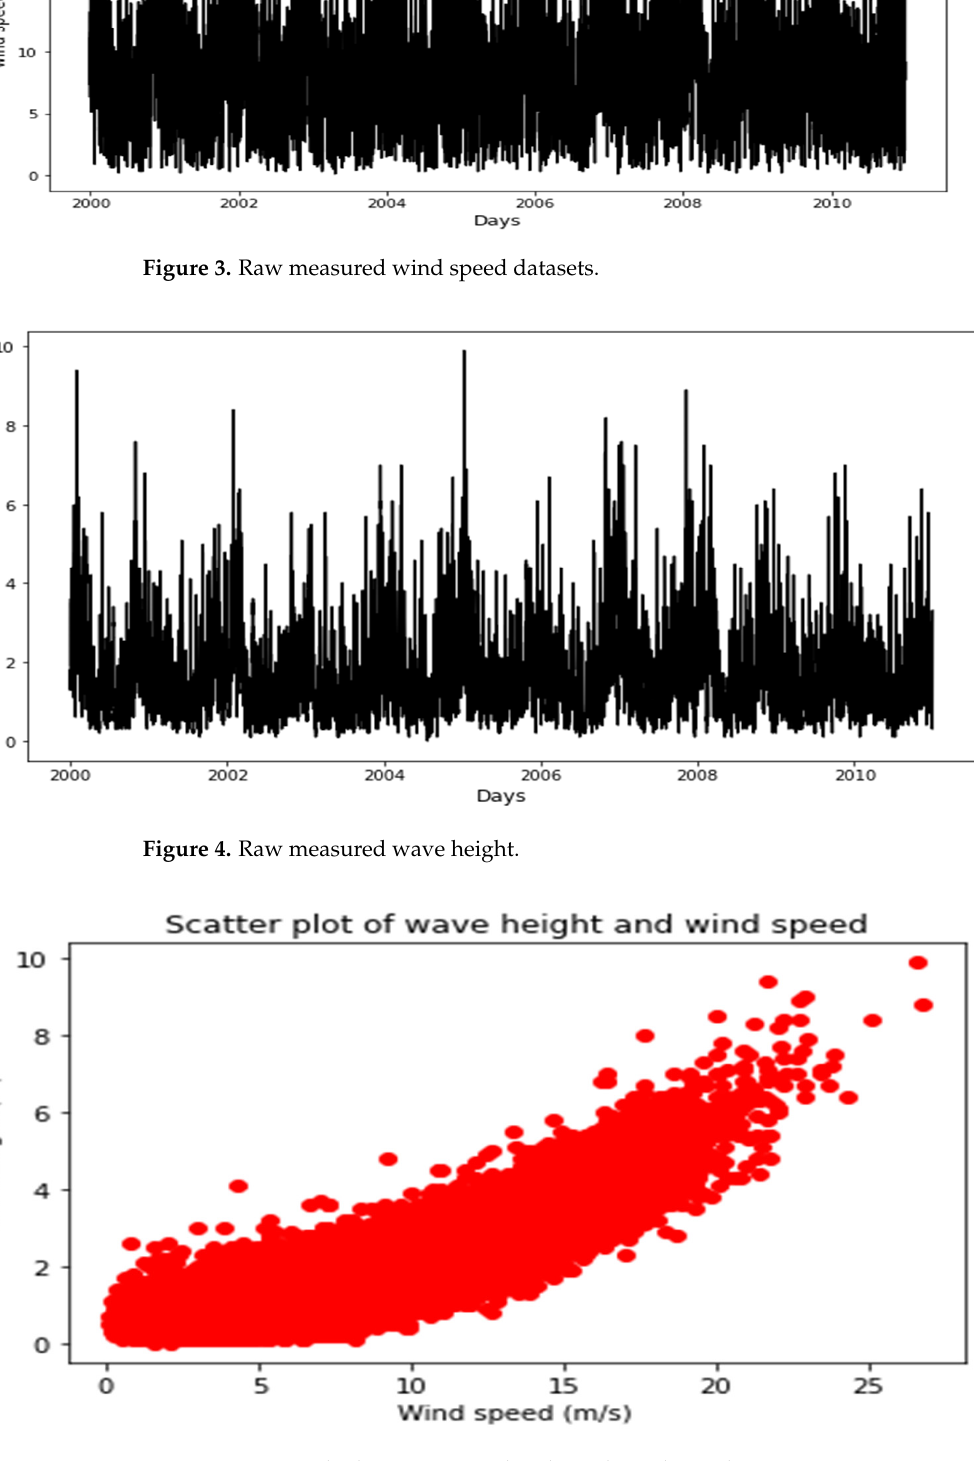
Figure 5. Scatter plot between wave height and wind speed.